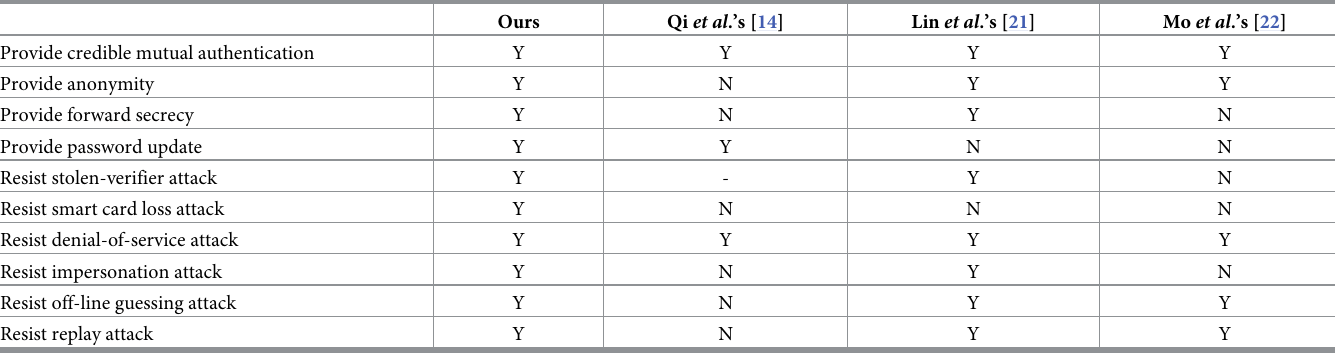
Table 3. Comparison of security features between our scheme and